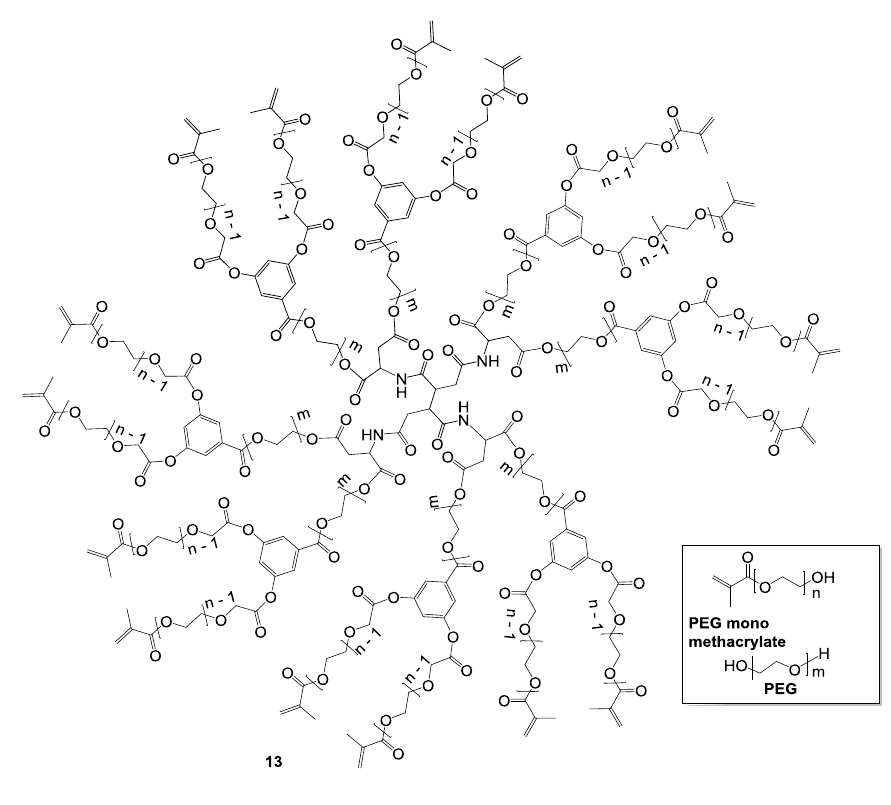
Figure 4. A novel second-generation dendrimer with a hydrophilic interior [102]. The letters m and n indicate the number of ethylene glycol